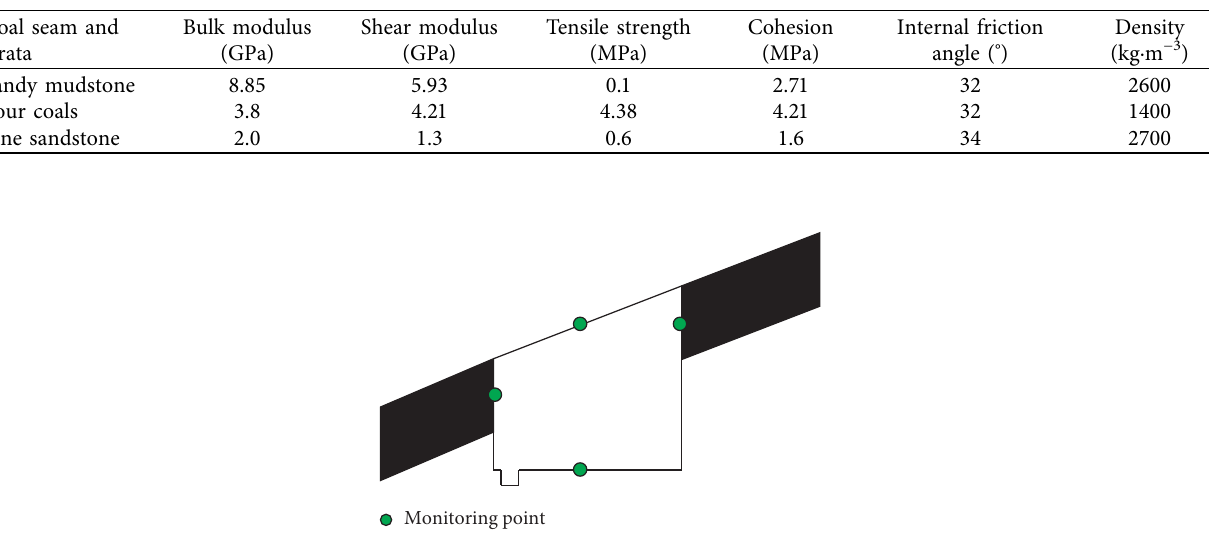
Table 1: Physical and mechanical properties of rock mass.